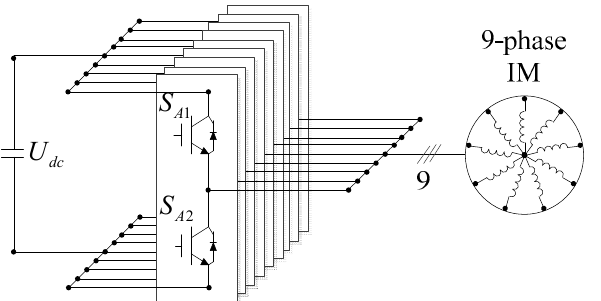
Figure 1. Symmetrical nine-phase induction motor supplied from a two-level voltage source in- verter (VSI).